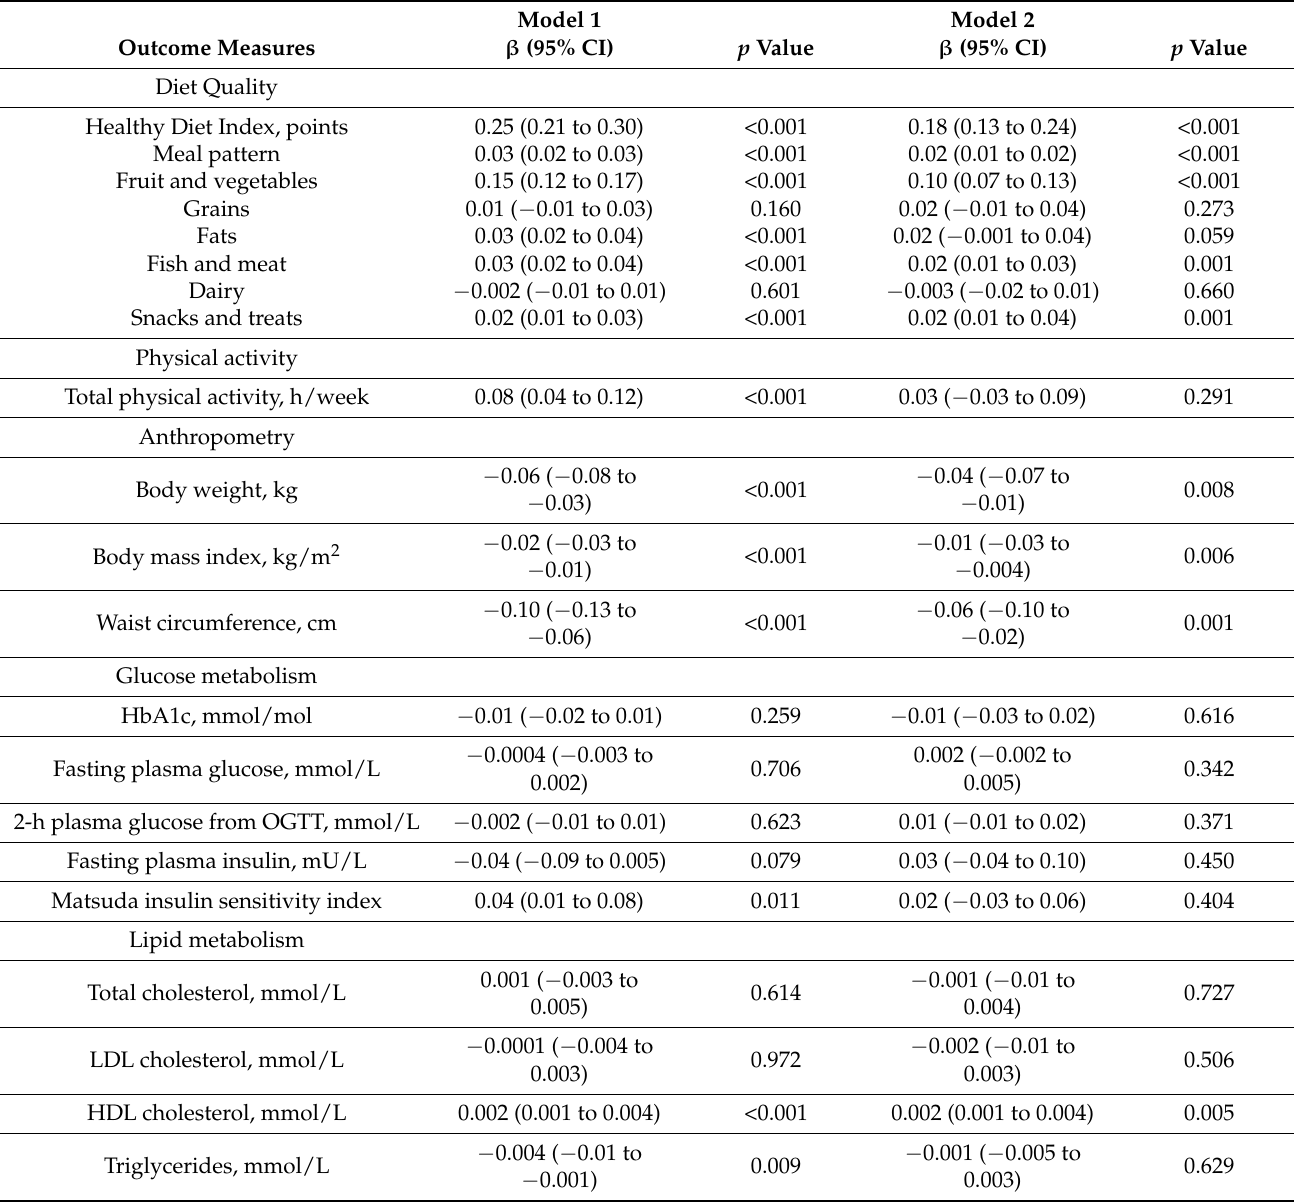
Table 2. Associations of changes in eating competence (EC) total score with changes in lifestyle and metabolic factors over one